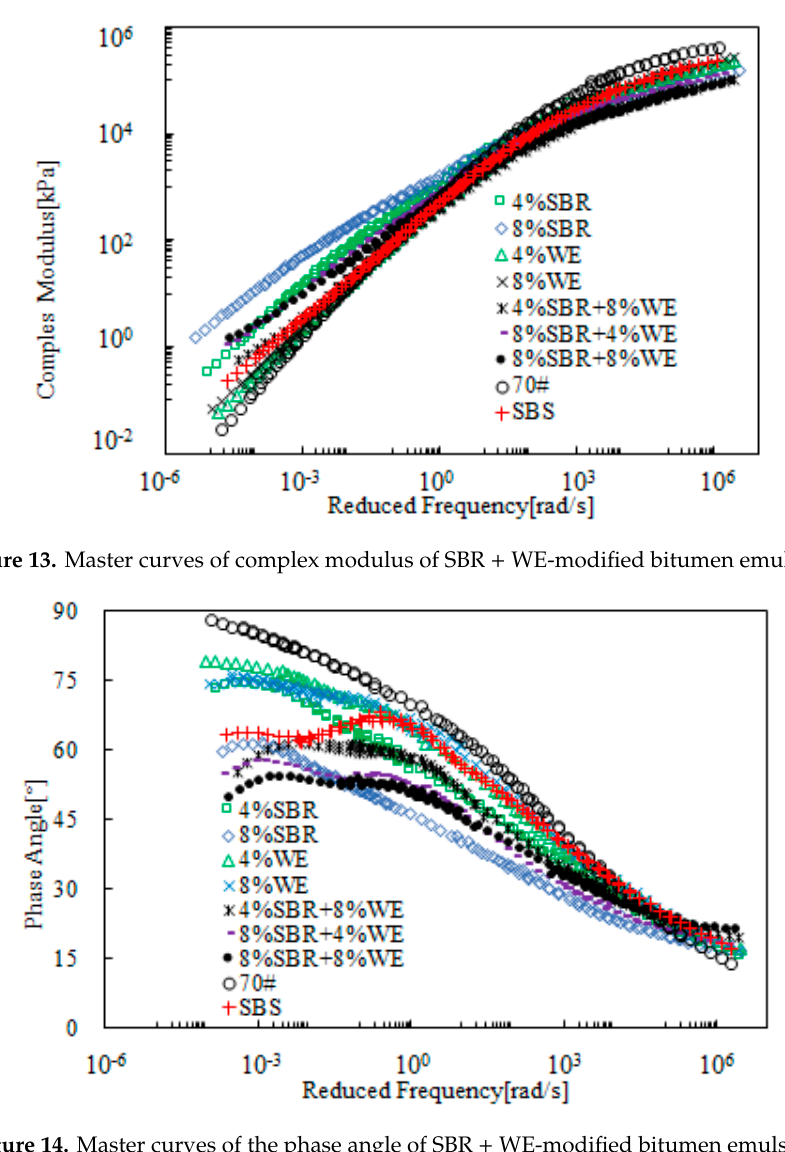
Figure 12. Master curves of the phase angle of SiO 2 -modified bitumen emulsion.